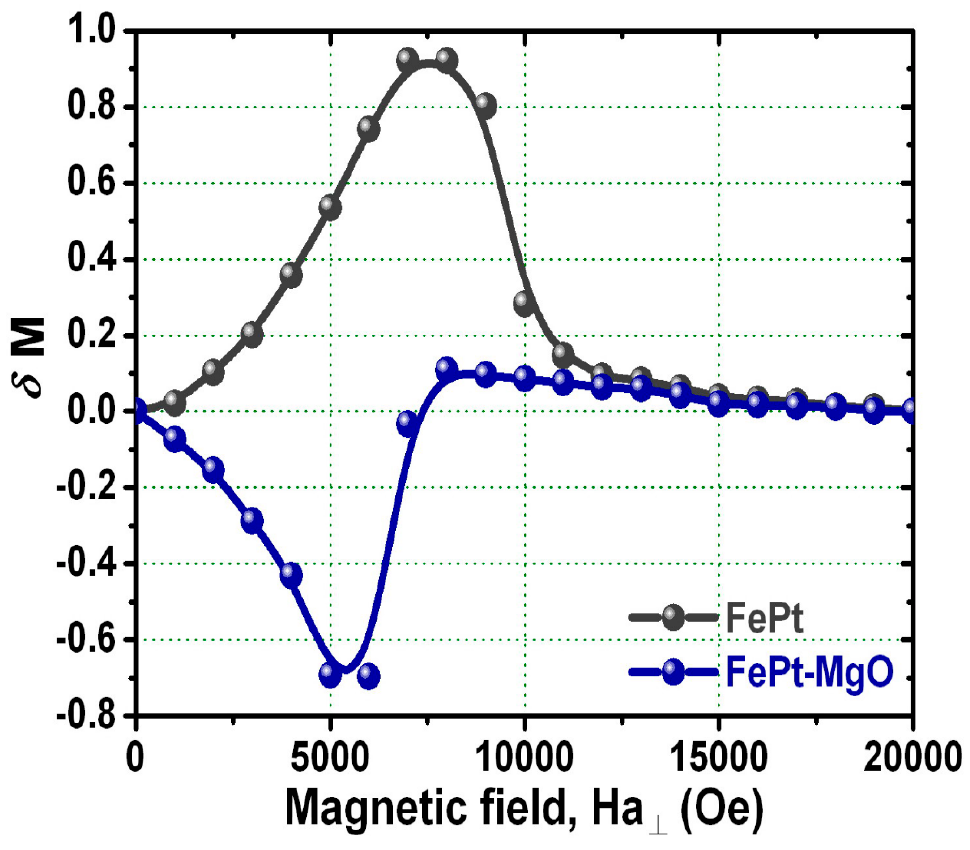
Figure 5. δ M measurement of the FePt films without and with MgO additive nanolayers are with the external field applied perpendicular to the film plane direction.